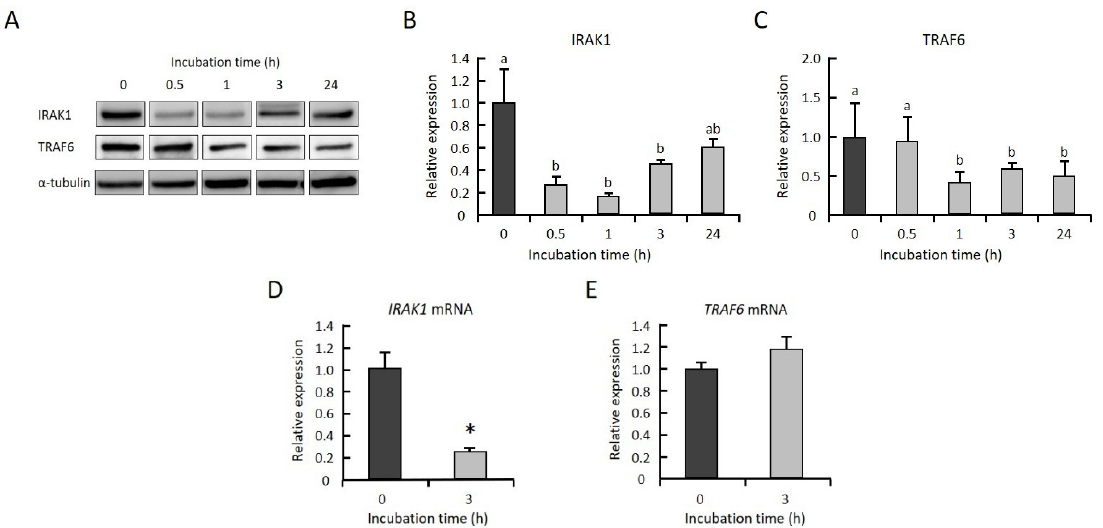
Figure 4. GGOH decreases the protein levels of both IRAK1 and TRAF6 but decreases the mRNA levels of only IRAK1. ( A – C ) Di ff erentiated THP-1 cells were incubated with 10 µ M GGOH for 0, 0.5, 1, 3, and 24 h. The cells were harvested, and the protein levels of IRAK1 ( B ) and TRAF6 ( C ) were measured by western blot, as described in the experimental procedures. All values represent the mean ± SEM; n = 3. The values with di ff erent letters (a and b) are significantly di ff erent at p < 0.05, as assessed by one-way analysis of variance, followed by the Fisher’s least significant di ff erence test. ( D , E ) The cells were harvested, and the RNA was isolated, as described in the experimental procedures. mRNA levels of IRAK1 ( D ) and TRAF6 ( E ) were then measured by quantitative RT-PCR. All values represent the mean ± SEM; n = 3. * The values are significantly di ff erent compared with those at time 0 at p < 0.05, as assessed by Student’s t -test.